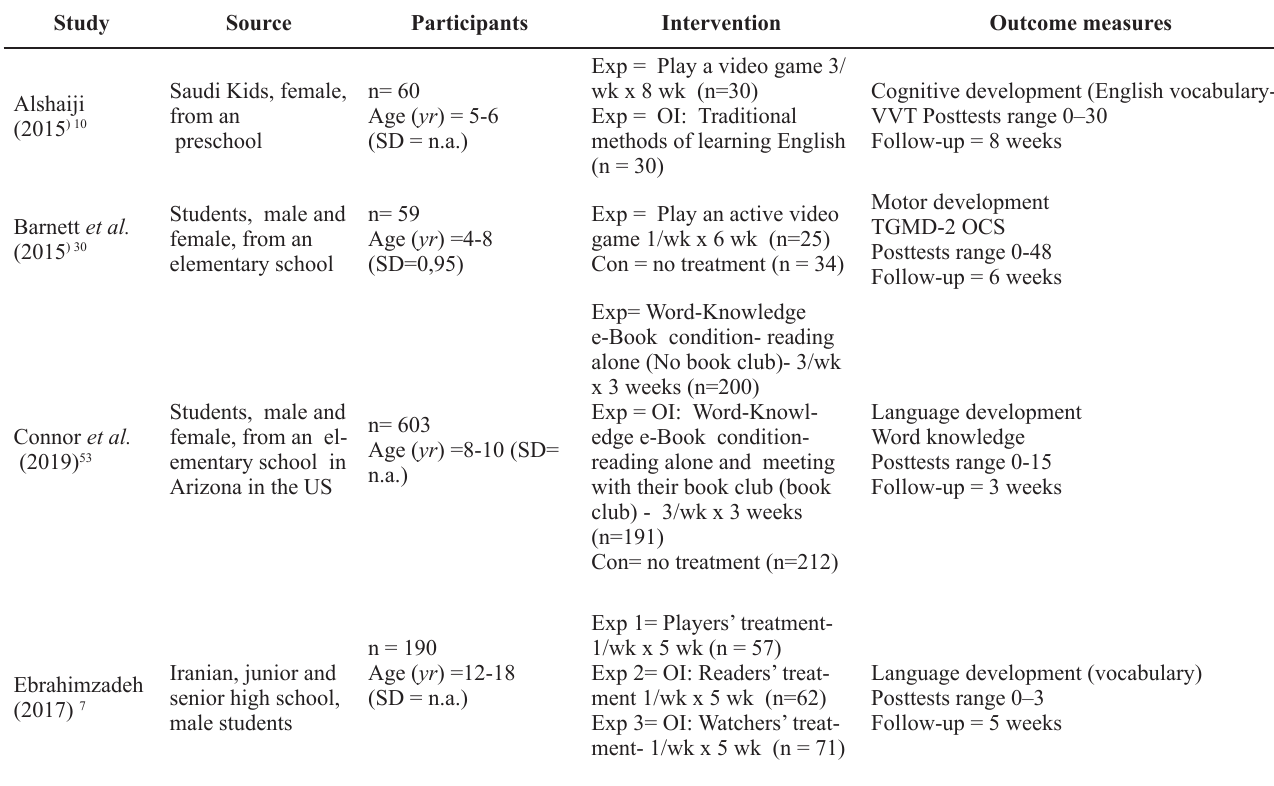
Table 1- Characteristics of the included studies (n =